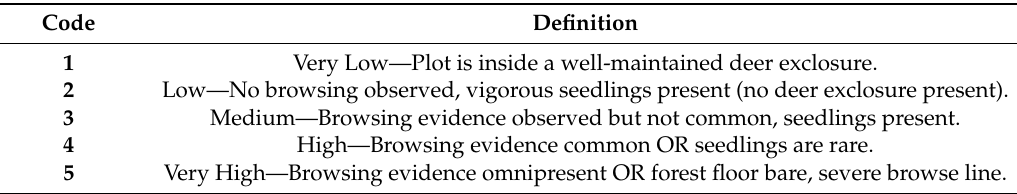
Table 1. Forest Inventory and Analysis (FIA) deer impact index assessment